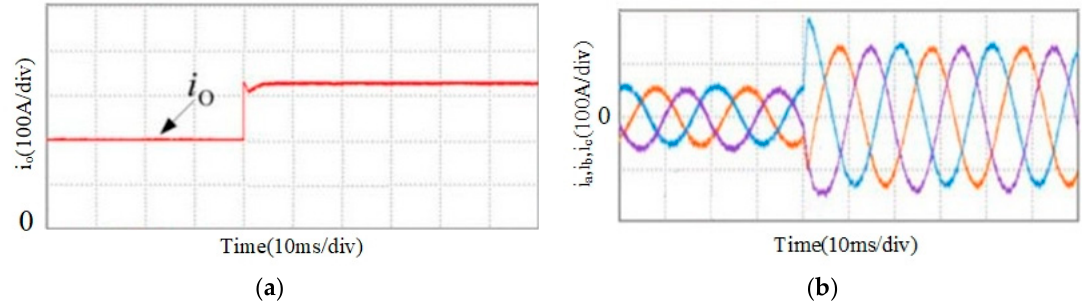
Figure 14. The experiment waves of a single rectifier module: ( a ) Output current wave; ( b ) three-phase AC current waveform.